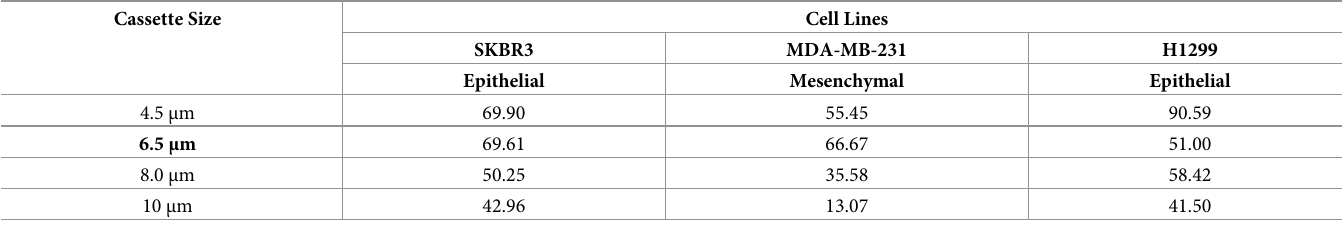
Table 1. Capture percentage across cell separation cassette sizes. Cassette Size